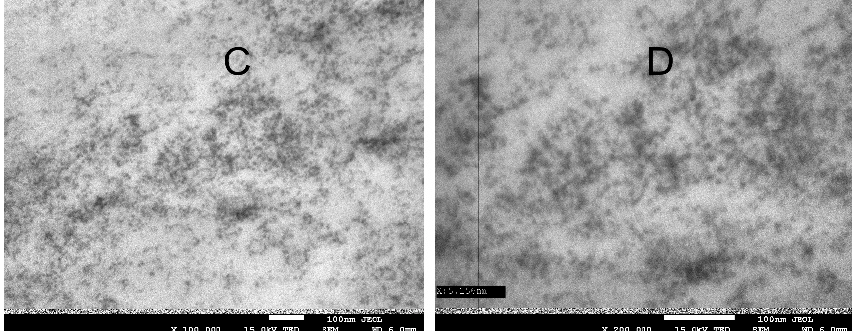
Figure 2. SEM/TEM image of the biocomposites: ( A )—control, ( B )—QD ‐ CdS, and ( C , D )—QD ‐ ZnS, at ×100,000, ×200,000 zoom, respectively.